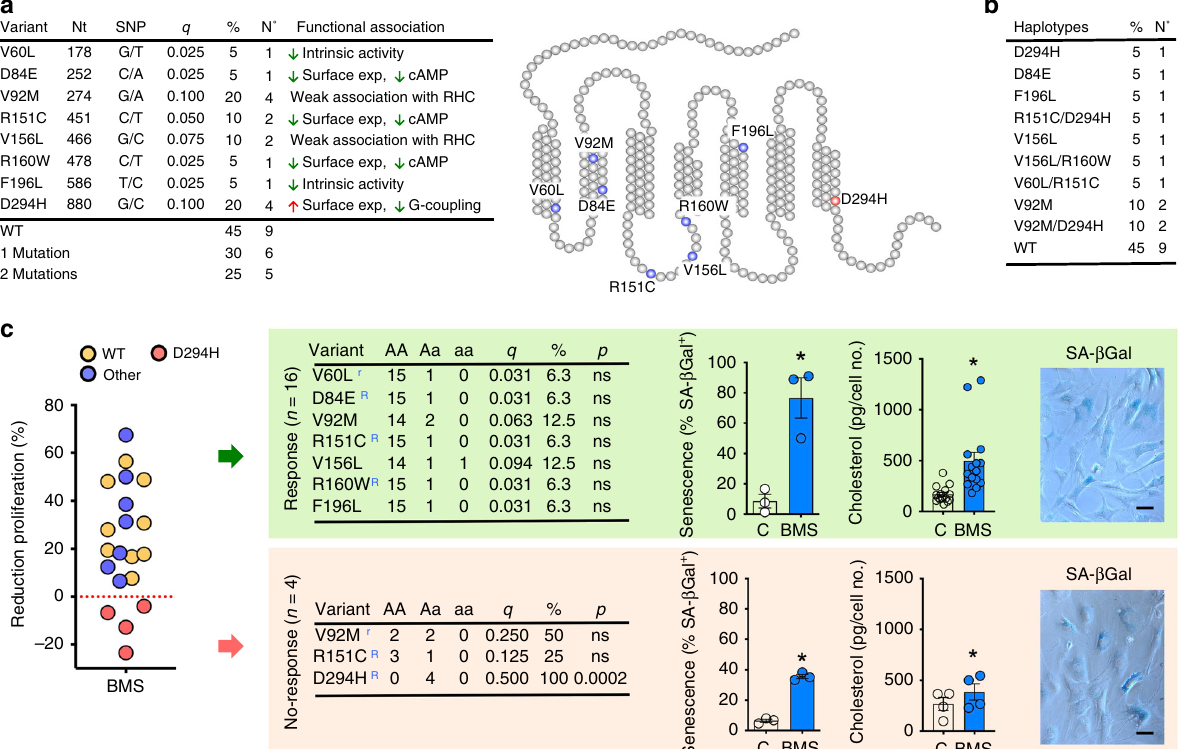
Fig. 7 Association of MC1R gene variants with induction of SF senescence. a MC1R variants identi fi ed in our study participants. Table includes variant name, position of nucleotide changed (Nt), speci fi c nucleotide change (SNP), variant allele frequency (q), percentage (%), and number of patients (No.) and functional outcome described in literature for each variant ( n = 20 patients). The location of each variant within MC 1 protein is shown in the scheme. b Percentage (%) and number (No.) of patients carrying each of the haplotypes identi fi ed (total n = 20). c Effect of BMS on proliferation of SF cell lines obtained from each of the 20 patients genotyped. Patient cells cluster into responders ( n = 16, green panel) and non-responders ( n = 4, yellow panel) according to the effect of BMS in the proliferation assay. For each group, the MC1R variant analysis is shown (A: consensus allele; a: variant allele; q: allele “ a ” frequency; %: proportion of allele “ a ” carriers; p: p value two-tailed Fisher ’ s test). Moreover, superscript R: high penetrance red hair variant; superscript r: weakly associated with red hair. Quanti fi cation and images of SA- β Gal staining are shown for each group (scale bars indicate 100 μ m) as well as cholesterol production measured by enzyme immunoassay. Data are mean ± SE (Student ’ s t -test vs. control, C, * p < 0.05). Source data are provided as Source Data fi